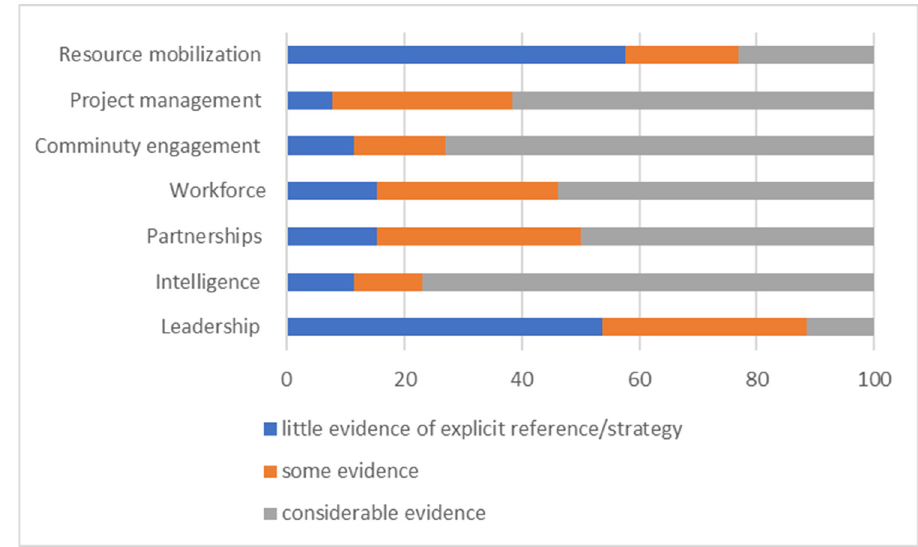
Figure 2. Levels of evidence pertaining to capacity building domains.